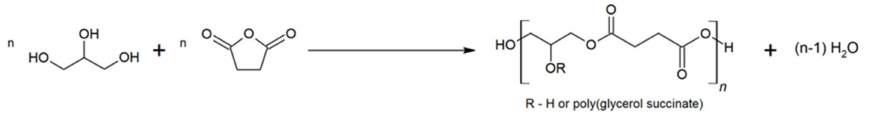
Figure 2. Synthesis of PGSu from succinic anhydride and glycerol.